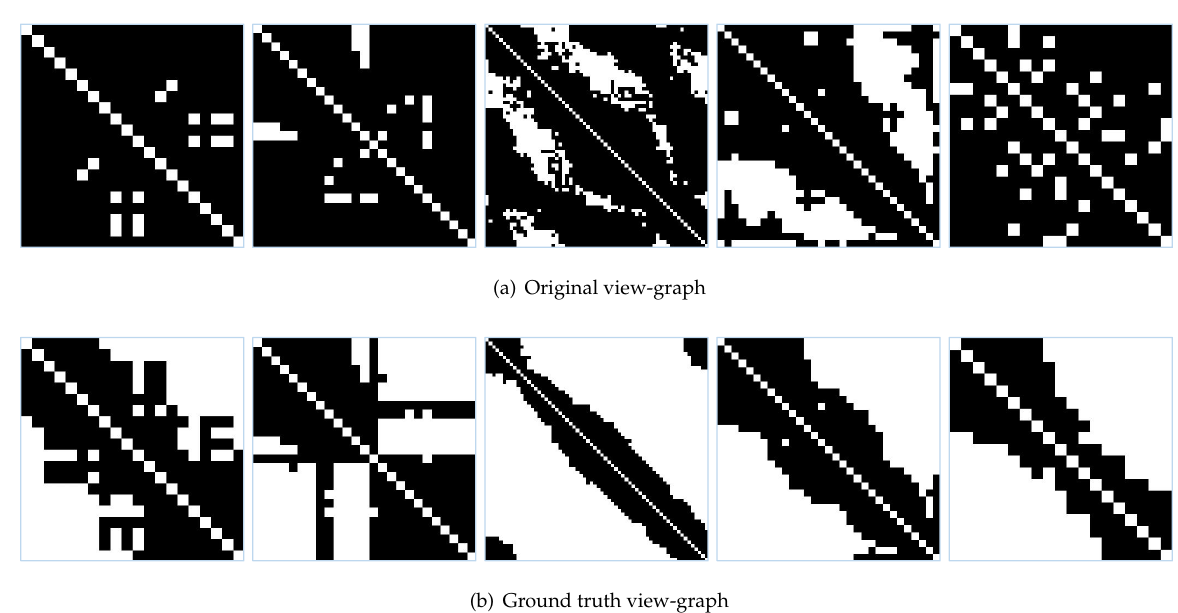
Figure 10. Adjacency matrices of view-graph for five small datasets. From left to right: Books , Cereal , Cup , Desk , Street .